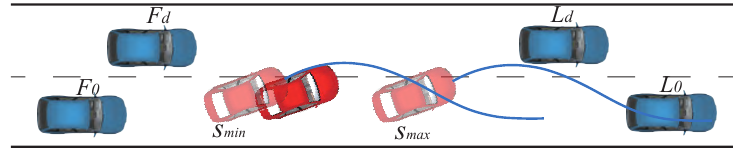
Figure 10. The minimum and maximum longitudinal position for lane-change